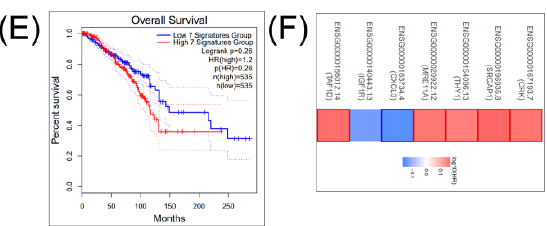
Figure 4. A common CSC and EMT downregulated miRNA expression signature in BRCA. ( A ) A Venn diagram of the downregulated genes of CSCs and EMTs in BRCA (downloaded from NCBI), as well as a signature of common miRNAs for both CSC and EMT transcript lists; bold-lettered genes predict the overall survival. ( B ) miRNAs capable of predicting the overall survival (miR-1, miR-100, miR-125b, miR-139, miR-145, miR-205, miR-224, miR-483, and miR-99b). ( C ) An interaction network using miRTargetLink software (strong interaction) for miRNAs involved in both CSCs and EMT and correlated with the overall survival. ( D ) An overall survival analysis for genes targeted by miRNA and correlated with the survival rate (TAF1D, IGF1R, CXCL3, MRE11A, THY1, SRGAP1, and CRK). ( F ) A survival map of the seven-gene signature.